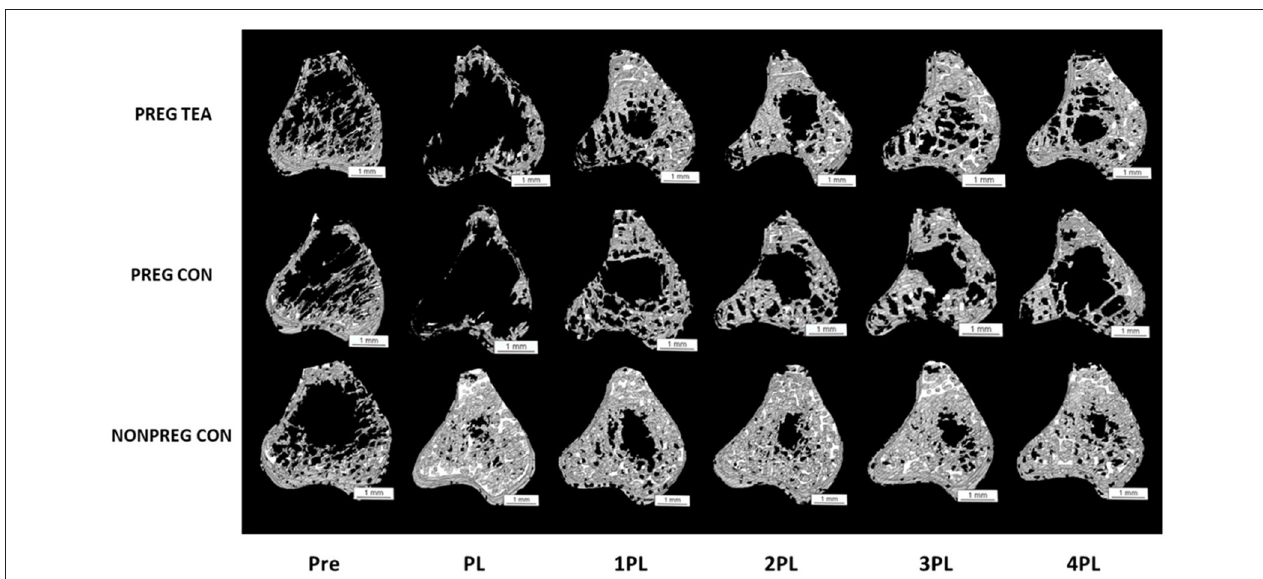
FIGURE 3 | Representative 3D images of trabecular bone from right proximal tibia in female Sprague-Dawley rats pre-pregnancy, post-lactation, and 1, 2, 3, and 4 months post-lactation. Representative scans for each group are of the same rat at each time point and images were chosen by selecting the rat with the closest value for BV/TV to the group mean. Pre, pre-pregnancy; PL, post-lactation; 1PL, 1 month post-lactation; 2PL, 2 months post-lactation; 3PL, 3 months post-lactation; and 4PL, 4 months post-lactation. The white bar under each scan represents a length of